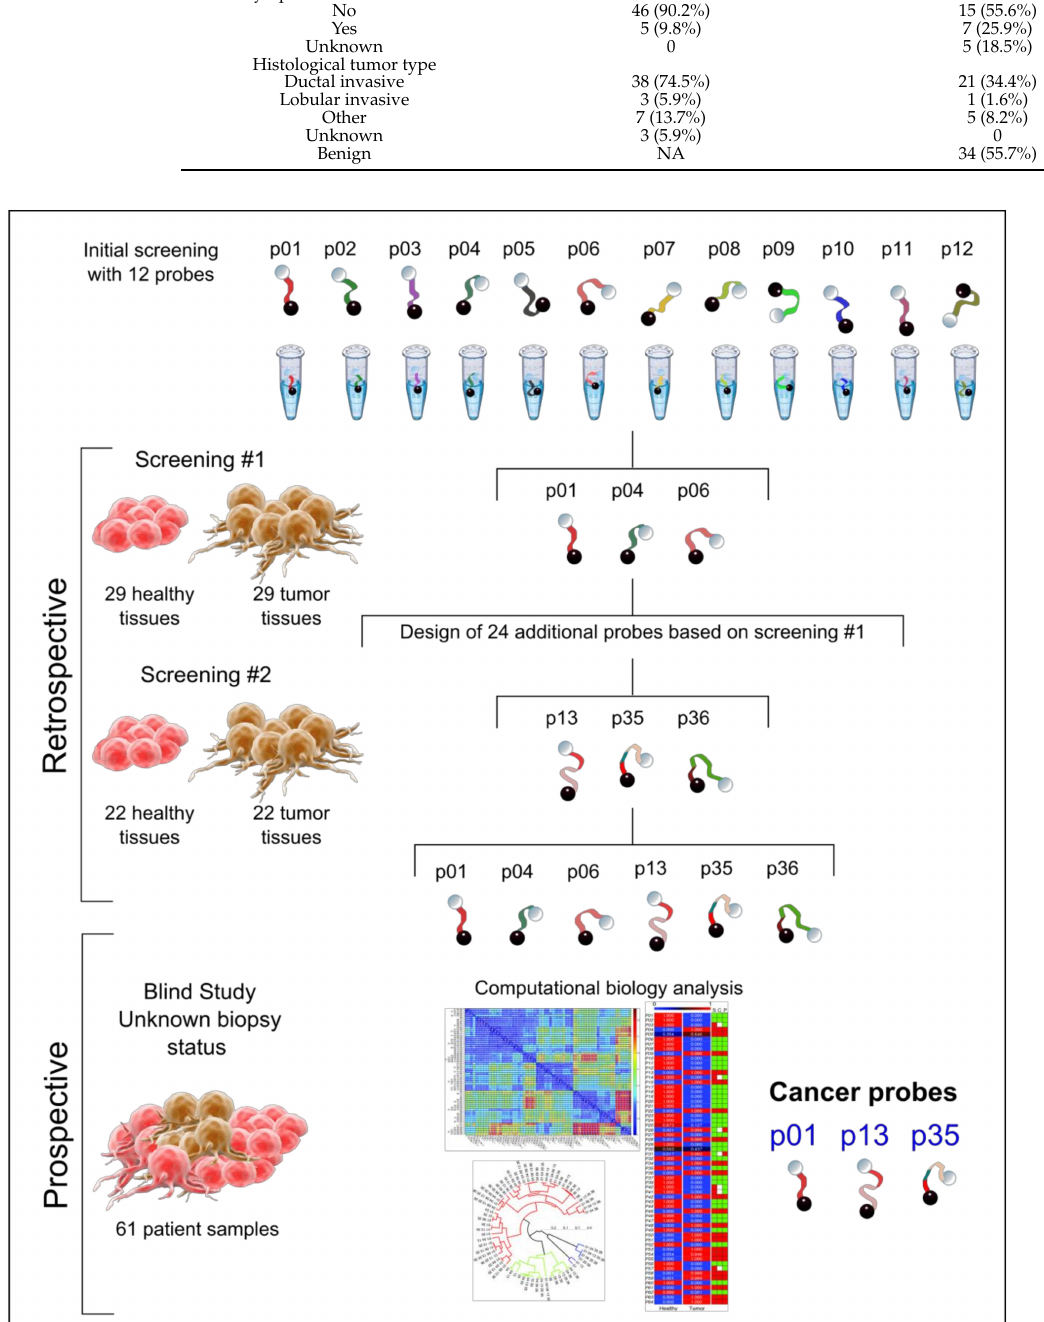
Figure 1. Study workflow: nuclease activity screening and computational biology analysis.